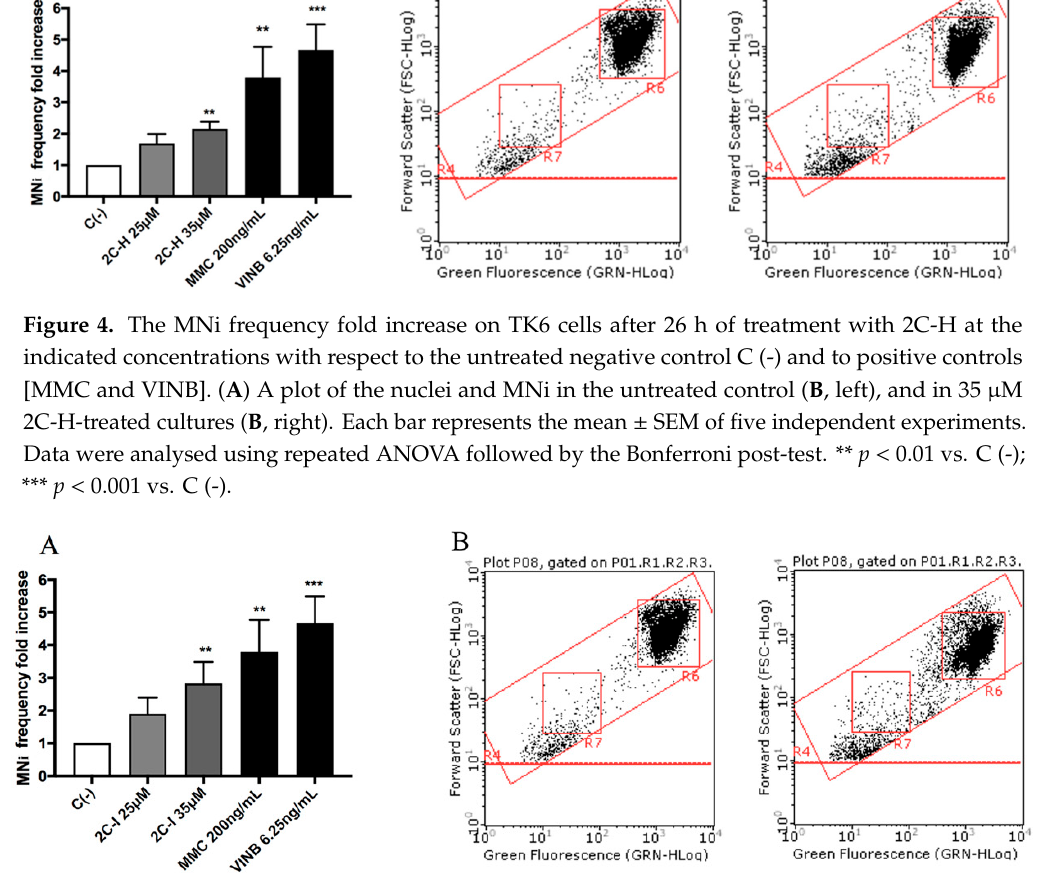
Figure 5. The MNi frequency fold increase on TK6 cells after 26 h of treatment with 2C-I at the indicated concentrations with respect to the untreated negative control C (-) and to positive controls [MMC and VINB]. ( A ) A plot of the nuclei and MNi in the untreated control ( B , left), and in 35 µM 2C-I-treated cultures ( B , right). Each bar represents the mean ± SEM of five independent experiments. Data were analysed using repeated ANOVA followed by Bonferroni post-test. ** p < 0.01 vs C (-); *** p < 0.001 vs C (-).